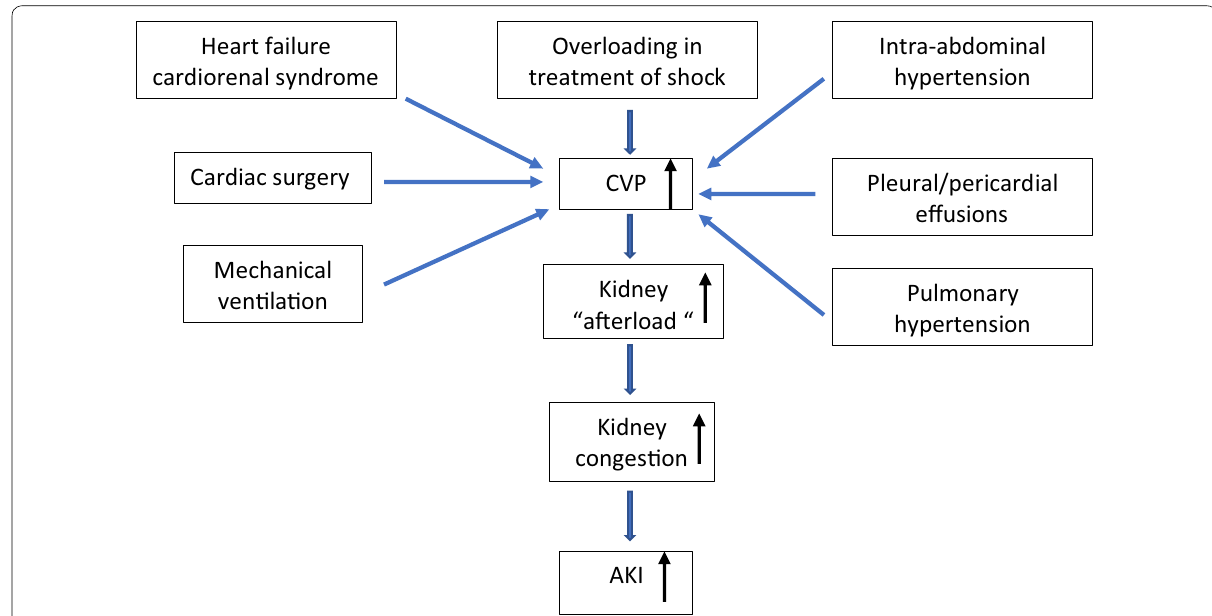
Fig. 1 Relationship of all-caused high CVP and AKI. CVP central venous pressure, AKI acute kidney